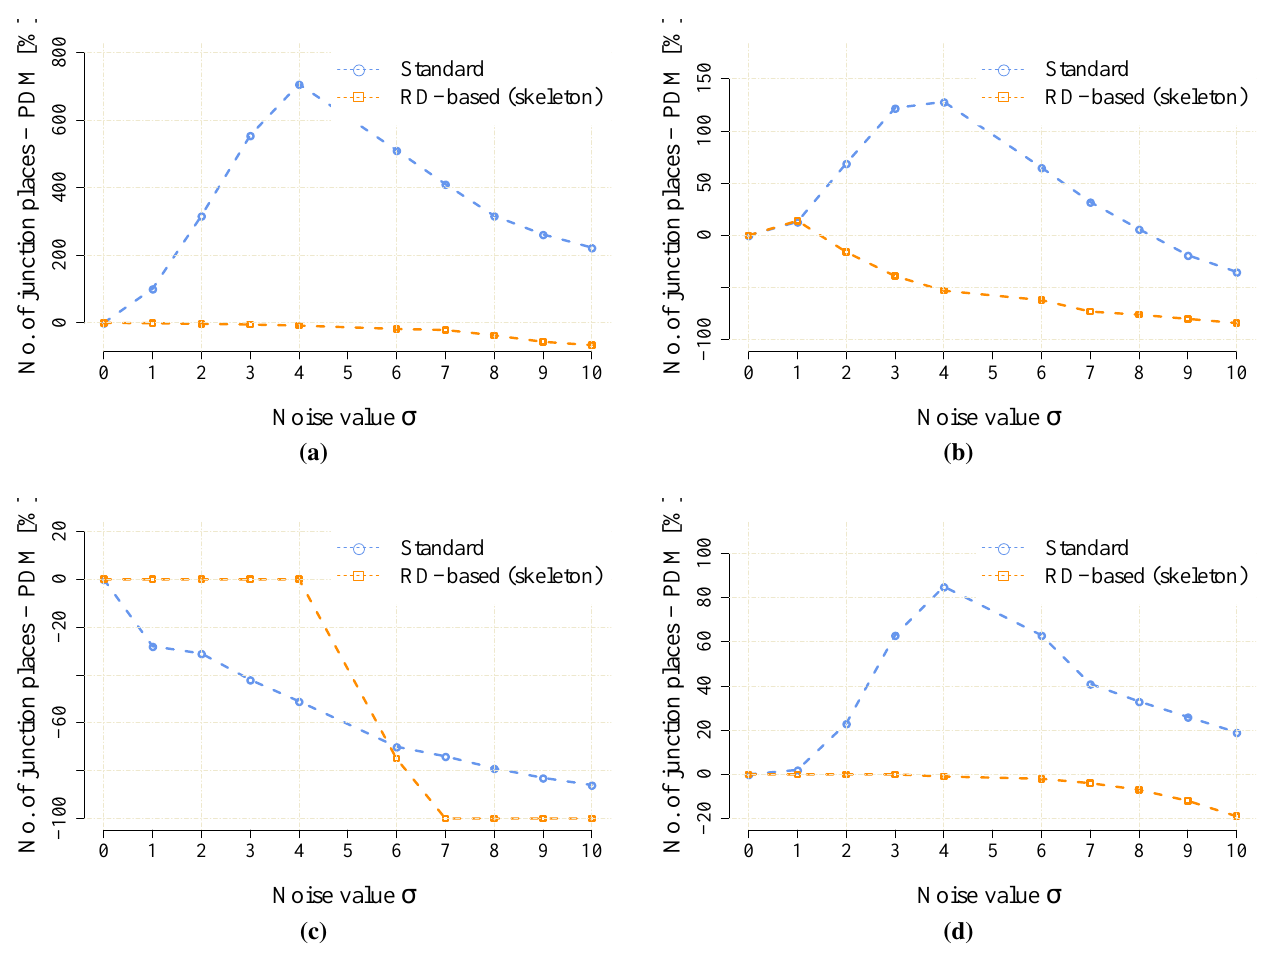
Figure 10. The noise sensitivity indicator JPDM Equation (3) in the noisy maps created for the particular value of the noise level σ . ( a ) environment autolab ; ( b ) environment jh ; ( c ) environment cube ; ( d ) environment potholes